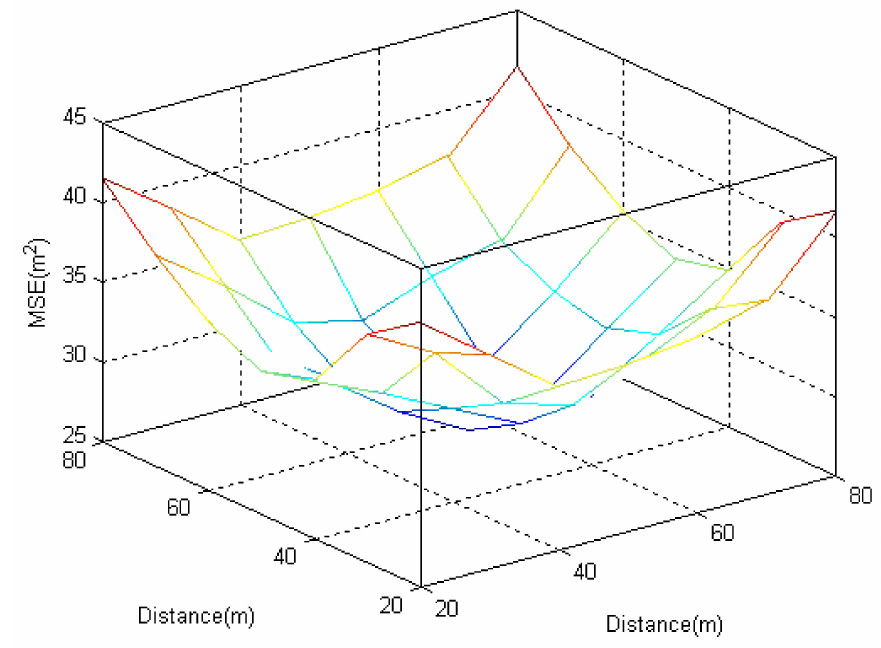
Figure 17. Four reference nodes to estimate the small range.